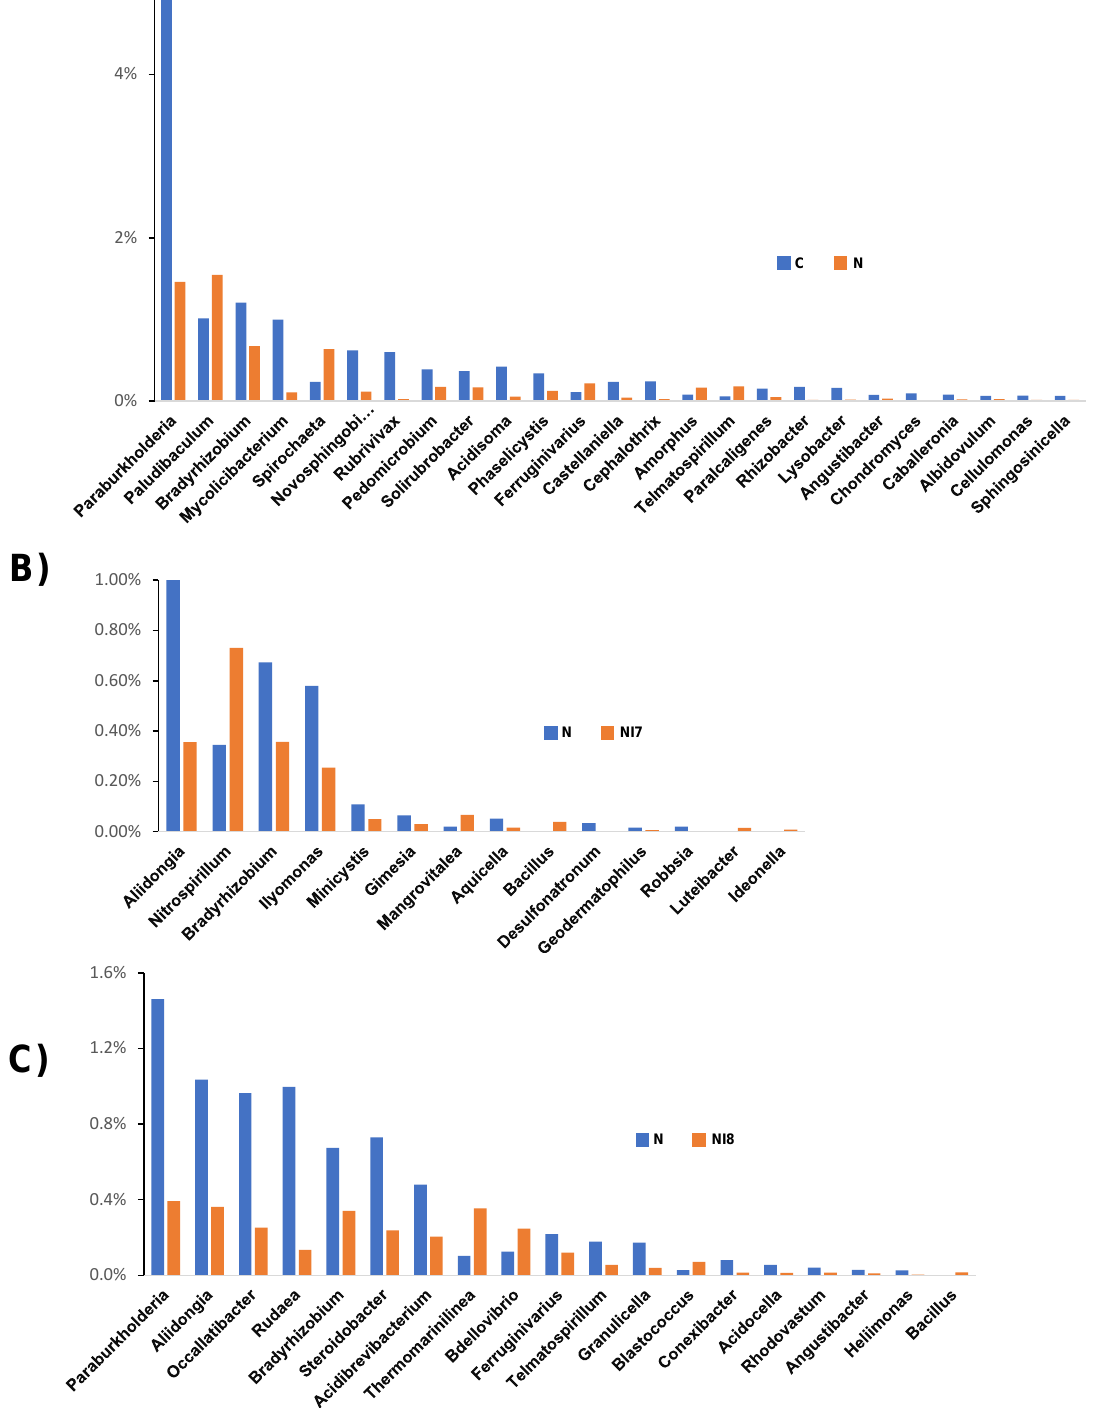
Figure 5. Bar graphs showing the relative abundance of rhizosphere bacterial genera from pine seedlings. Bacterial genera existed at significantly different ( p < 0.05) relative abundance levels between ( A ) nematode-inoculated and uninoculated control pine seedlings, ( B ) nematode-inoculated control seedlings and nematode-inoculated and IRP7-treated seedlings, and ( C ) nematode-inoculated control seedlings and nematode-inoculated and IRP8-treated seedlings. The bars represent the mean values of four